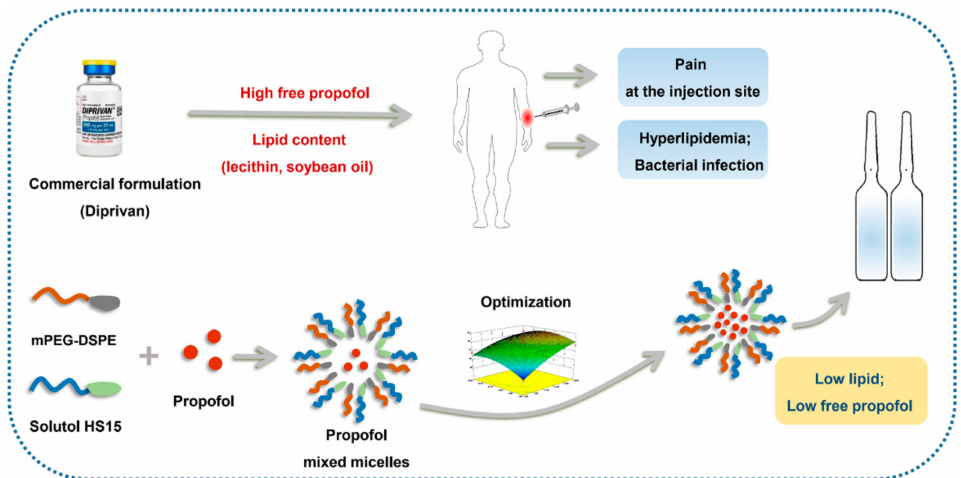
Figure 1. The schematic representation for the propofol mixed